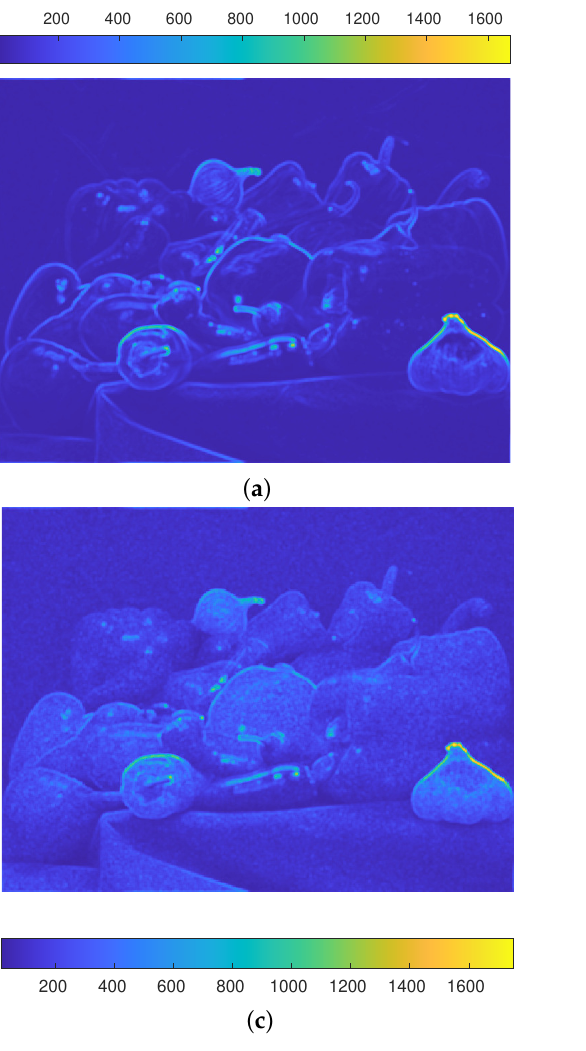
Figure 3. Colour distances on Peppers image. ( a ) proposed similarity index. Each pixel of this image depicts the proposed distance from its 4-neighbours. The smoothing effect promotes the difference between different objects and at the same time uniform coloured regions are discarded. ( b ) each pixel of this image depicts the classical Euclidean distance from its 4 neighbours. Several unwanted details are maintained inside the object of interest. ( c ) proposed similarity index in presence of Poisson noise. This distance preserves the boundary between objects of different colours. ( d ) classical Euclidean distance in presence of Poisson noise. The majority of colour information is lost due to the noise affecting the image. Remark 2. The two terms in the functional in (16) could be considered as a “fidelity term”, ) part, and a regularising term, the β log ( x ) the α log ( S